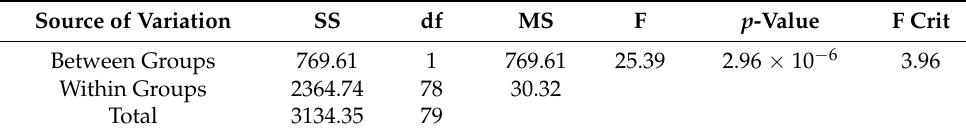
Table 7. Single-factor ANOVA